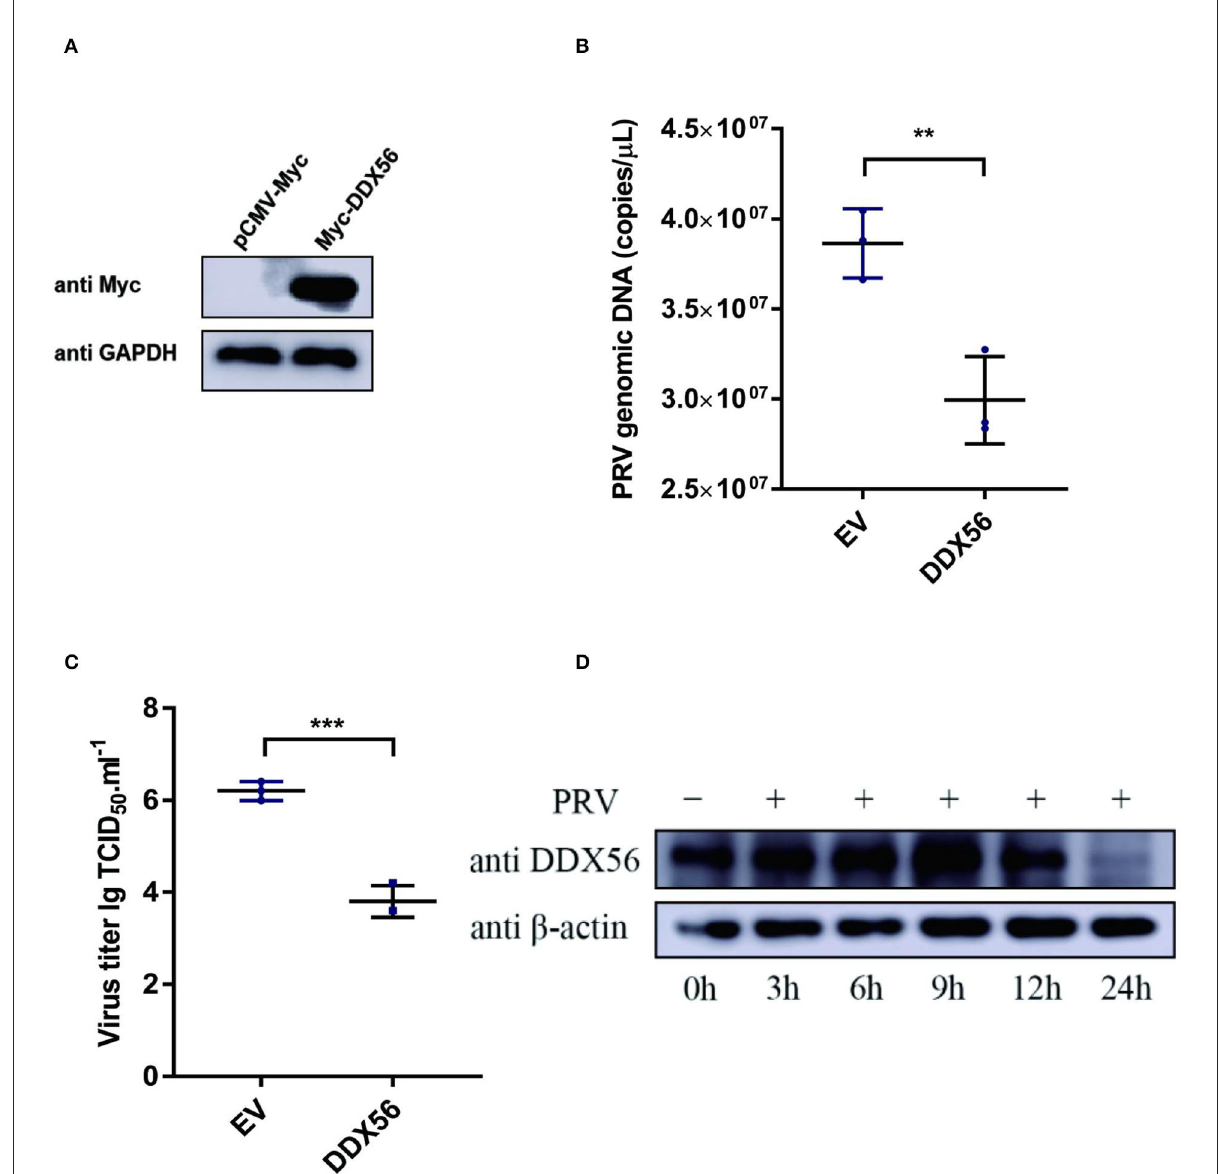
FIGURE1 Overexpression of DDX56 inhibits PRV replication in PK15 cells. (A) Empty vector (EV, 1 µ g) or the pCMV-Myc-DDX56 plasmid (1 µ g) was transfected into PK15 cells for 24h before measuring DDX56 (65 kDa) expression by immunoblotting. GAPDH (37 kDa) served as a loading control. (B,C) Empty vector (EV, 1 µ g) or the pCMV-Myc-DDX56 plasmid (1 µ g) was transfected into PK15 cells for 24h and then infected with 100 TCID 50 PRV for 24h before measuring PRV genomic DNA copy numbers and titers. Viral copy number was determined by Real-Time quantity PCR (B) and viral titer was detected by TCID 50 assay (Reed–Muench method) (C) . Data were listed as mean ± SD of three independent experiments and measured in technical duplicate. *** p < 0.001, ** p < 0.01. (D) PK15 cells were mock-infected or infected with 100 TCID 50